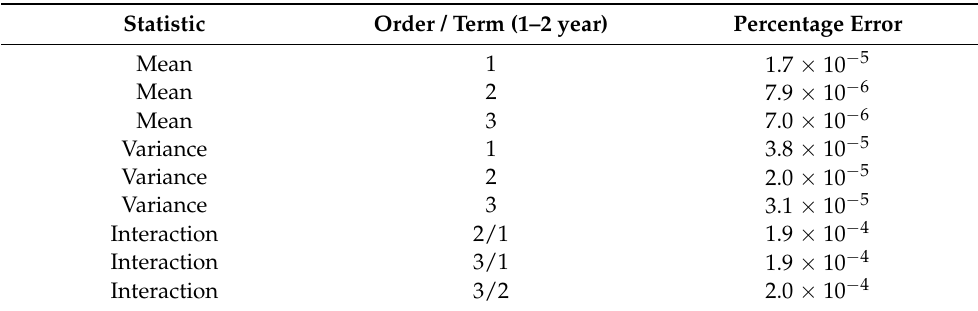
Figure 13. Analogous results to Figure 12 are shown for the variance decomposition. Here the full decompositions are displayed, and demonstrates the insensitivity to prescribed changes in the frequency distribution. Table 10. Numerical integration errors for the post-catXL HU only results for various terms presented in Figures 12 and 13 (analogous to Tables 3, 5, 7 and 9). Column 1 indicates the particular mean or total variance statistic, Column 2 has the occurrence loss order (or interaction term) for the 1–2 year return period layer and Column 3 has the percentage